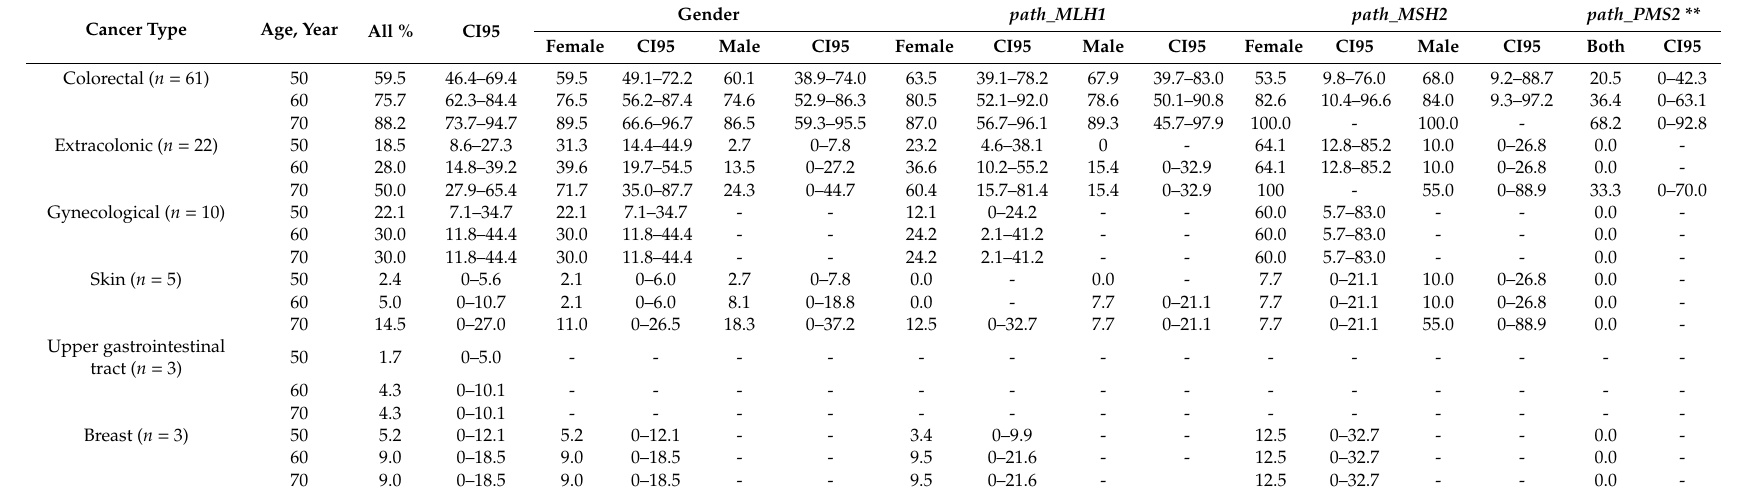
Table 4. Cumulative incidence (%) of colorectal and extracolonic cancers diagnosed before 75 years by age, gender and gene in path_MMR carriers (Group